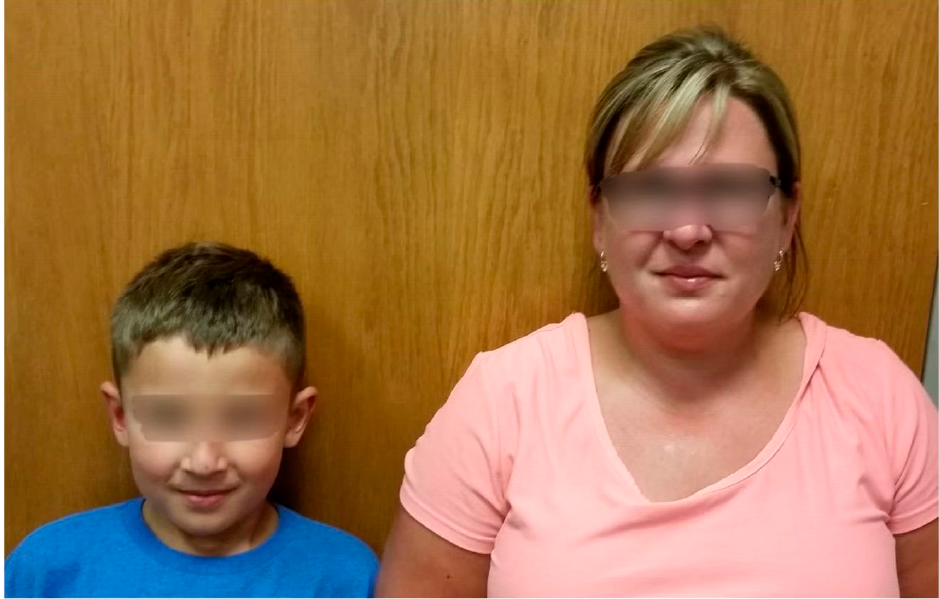
Figure 3. Frontal views of a mother and child with the 15q11.2 BP1-BP2 deletion (Burnside–Butler) Figure 3. syndrome.